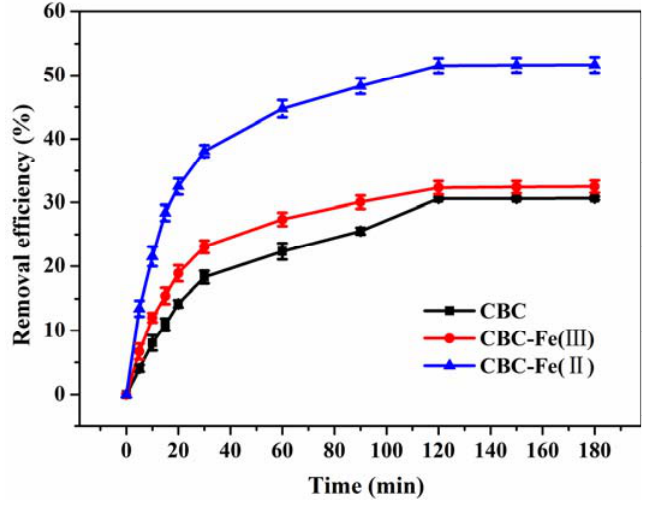
Figure 8. The influence of contact time on removal efficiency of RhB by CBC, CBC-Fe(III) and CBC-Fe(II) (adsorbent dosage: 30 mg; initial dye concentration: 600 mg/L).